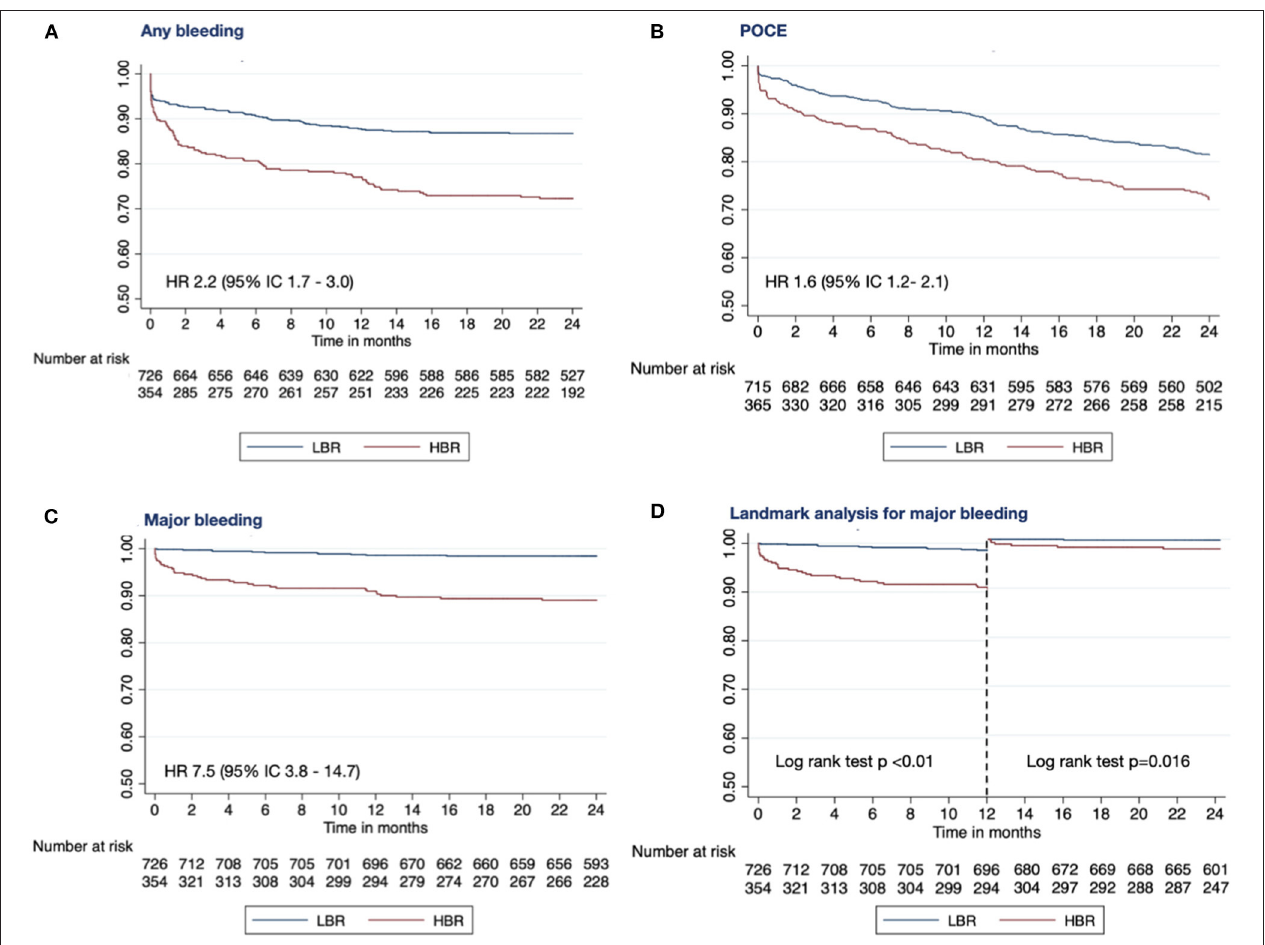
FIGURE 2 | Kaplan-Meier survival curves showing any bleeding (A) , POCE [composite of all-cause death, any myocardial infarction and any repeat revascularization; (B) ] and major bleeding (C) survival free at 2 years of follow-up. Landmark analysis (D) in patients with low-(LBR) and high-(HBR) bleeding risk. HBR, high bleeding risk; LBR, low bleeding risk; POCE, patient oriented composite